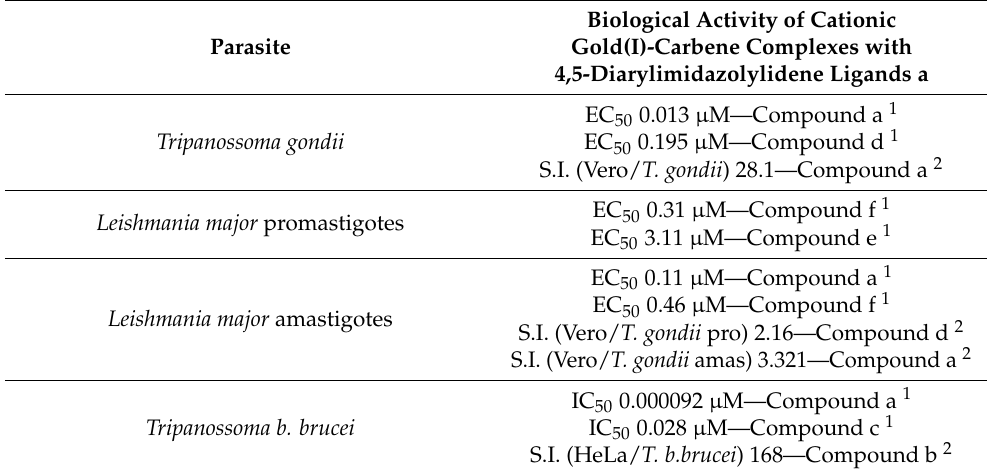
Table 3. Biological activity of cationic gold(I) carbene against Leishmania major , Toxoplasma gondii and Tripanossoma brucei parasites [44].